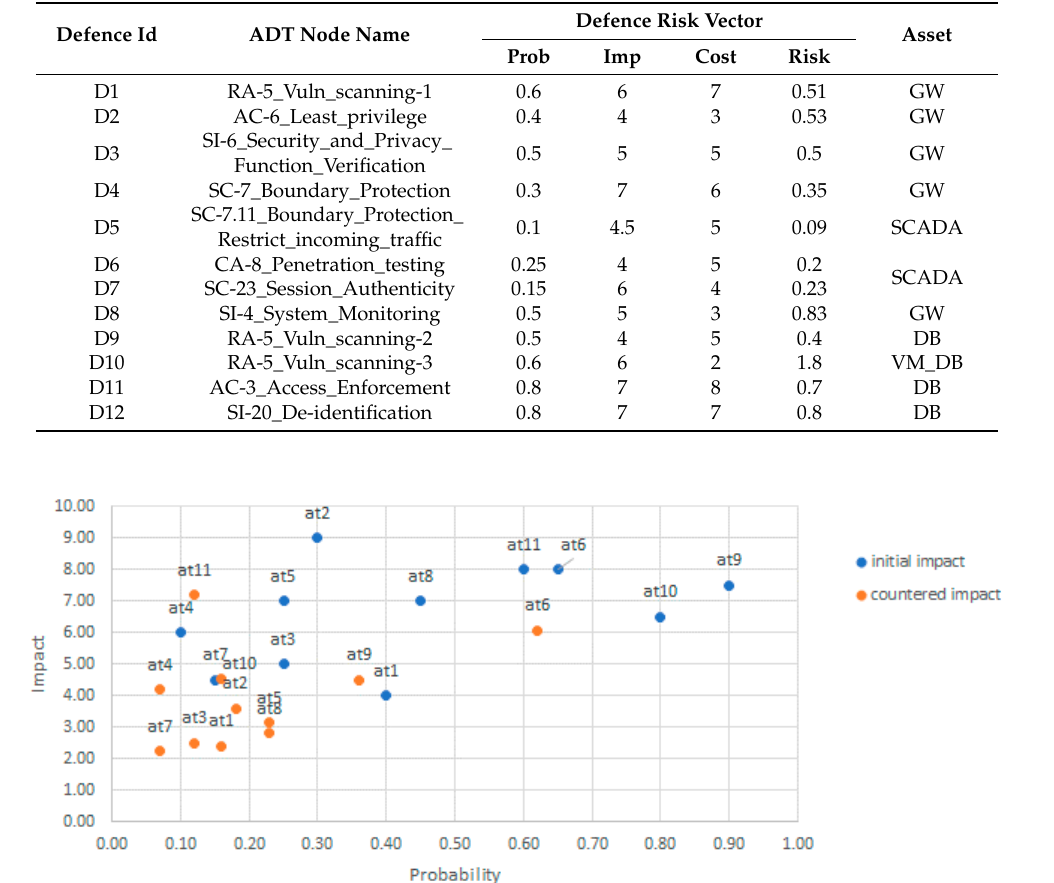
Figure 7. Severity of attack events in the use case before (blue) and after (orange) countermeasures.